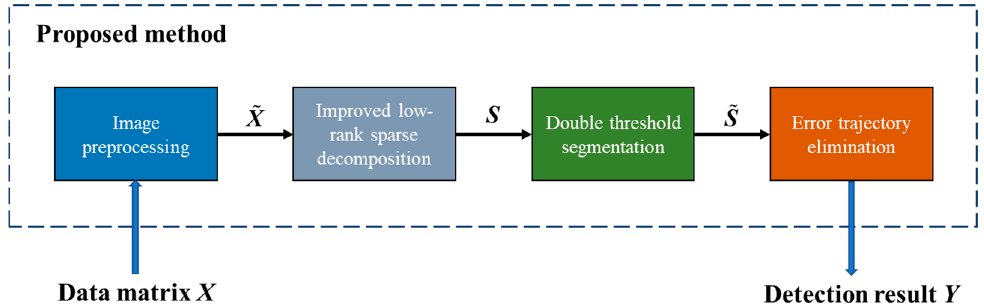
Figure 1. Algorithm flowchart.